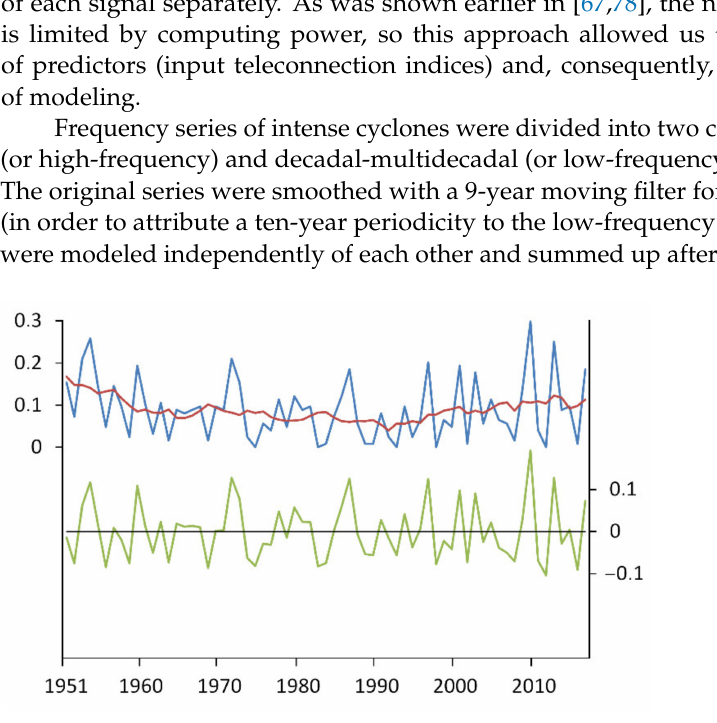
Figure 2. Frequency of intense cyclones in January (both y -axes) in the Western Mediterranean: the original series (blue line), high-frequency (green line), and low-frequency (red line)